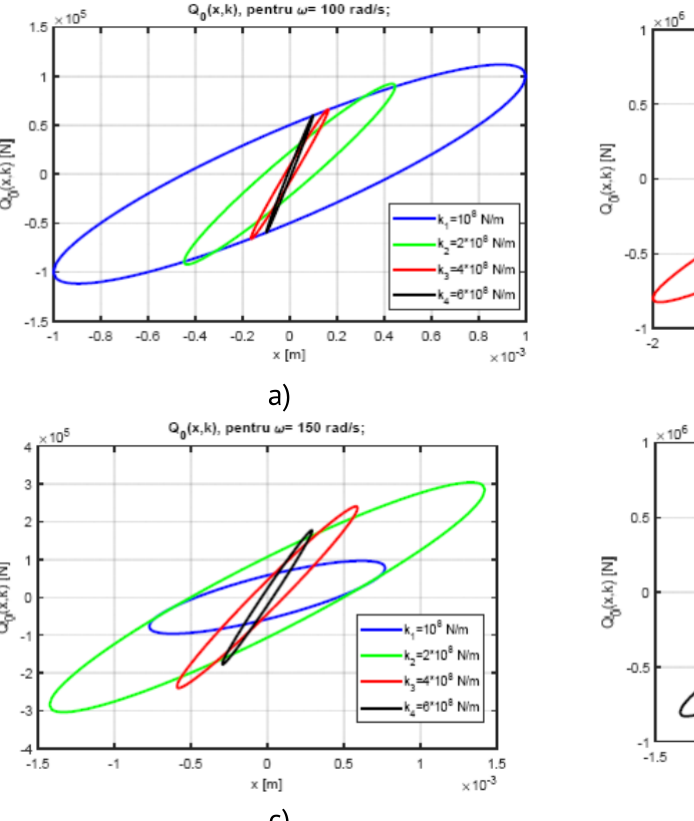
Figure 5. Q – x Hysteretic Ellipse